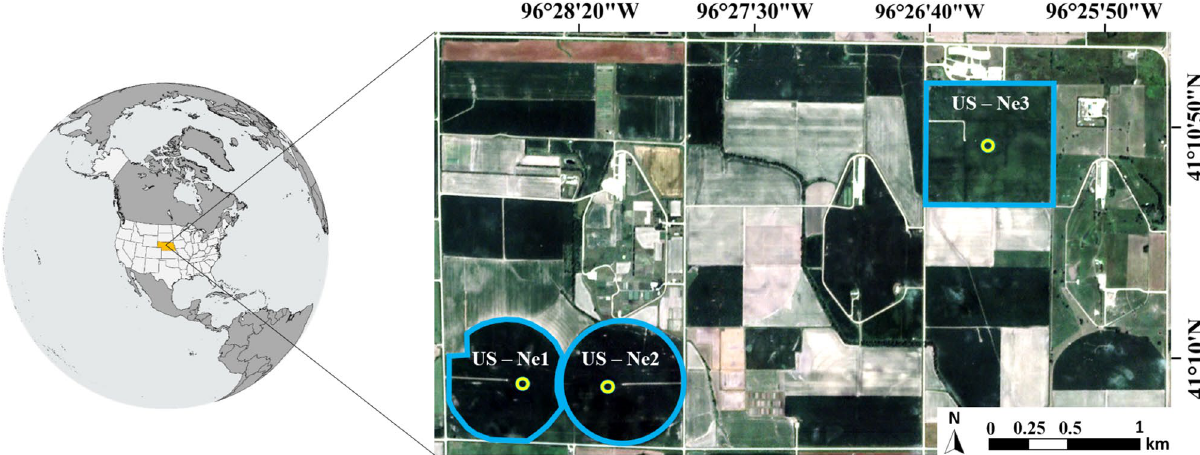
Figure 1. Location of the three field sites forming part of the University of Nebraska-Lincoln (UNL) Eastern Nebraska Research and Extension Center (ENREC) (see https:// exten sion. unl. edu/ state wide/ enre/). The blue lines represent the approximate boundary of each field, while green circles indicate the location of eddy covariance towers in each